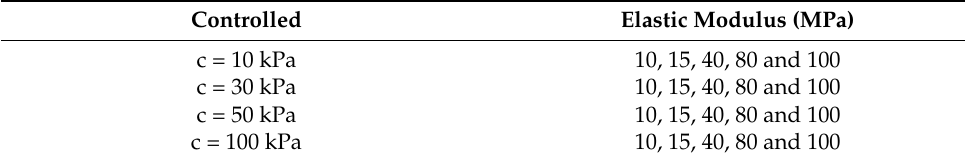
Table 5. Controlled parameters and varying